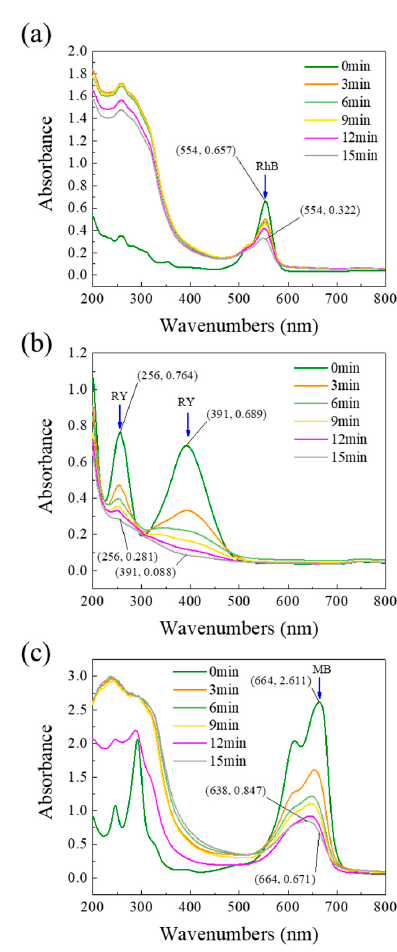
Figure 3. UV-Vis spectra of ( a ) RhB, ( b ) RY, and ( c ) MB solution during the photocatalytic degrada- tion process.